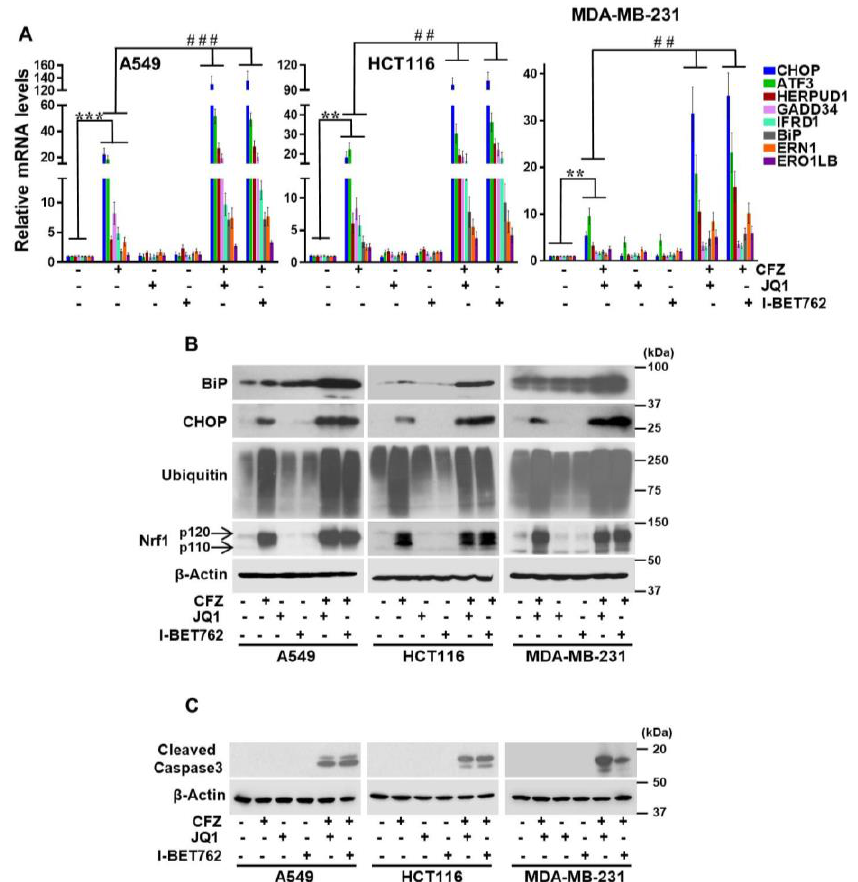
Figure 3. Combination of proteasome and BET inhibitors results in exacerbation of the UPR. ( A ) BET inhibitors (JQ1 1 µ M and I-BET762 10 µ M) and proteasome inhibitor (CFZ 200 nM) were added either alone or in combination to A549, HCT 116, and MDA-MB-231 cells for 8 h, as indicated. DMSO was used as the vehicle control. RNA was isolated from these cells and subjected to quantitative RT-PCR to measure transcript levels of select stress response genes, as shown. The mRNA levels of 18s rRNA were used for normalization. Error bars denote SD ( n = 3); ( B ) Cells treated as above were used for Western blot analysis employing specific antibodies as indicated and β -Actin was used as the loading control. The experiments were performed three independent times and a representative blot is shown; ( C ) A549, HCT116, and MDA-MB-231 cells were treated with BET inhibitors (JQ1 1 µ M and I-BET762 10 µ M) and proteasome inhibitor (CFZ 200 nM), similar as above, for 14 h and lysates were used to analyze cleaved caspase-3 using specific antibody. β -Actin served as the loading control. A representative blot of three independent experiments is shown. *, p < 0.05, **, p < 0.005, ***, and p < 0.0005 as compared with controls; #, p < 0.05, ##, p < 0.005, ###, and p < 0.0005 as compared with the CFZ-treated group.